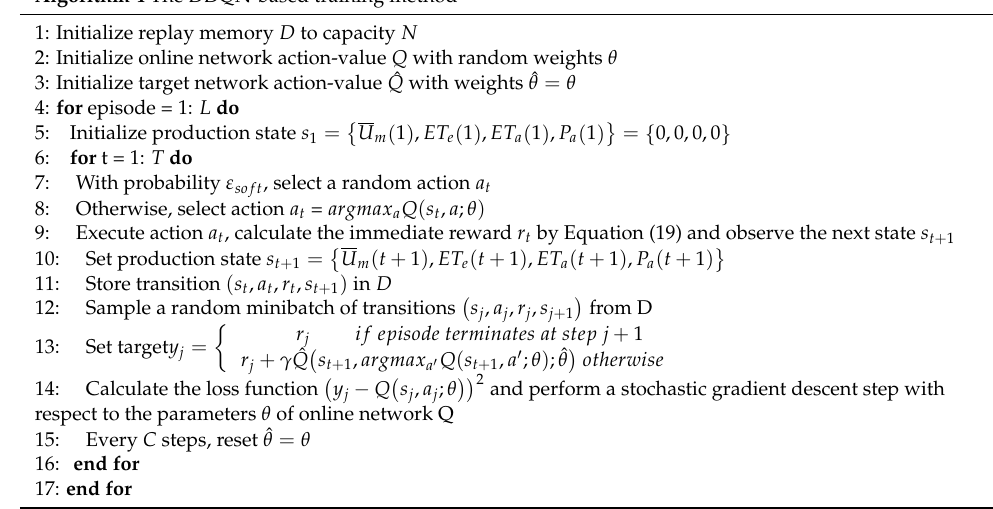
Algorithm 4 The DDQN-based training method